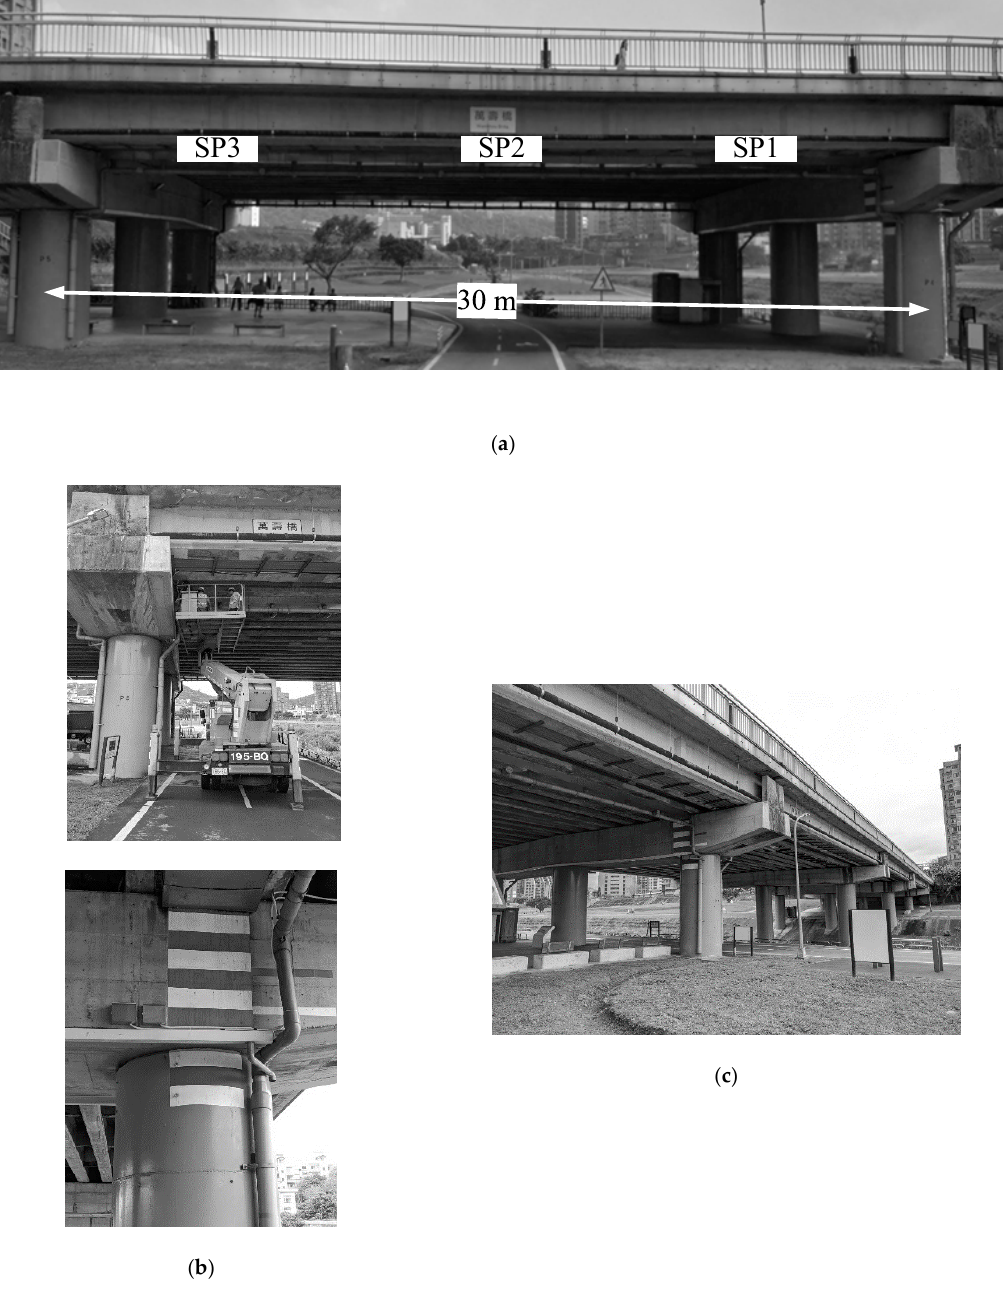
Figure 26. ( a ) Sensor positions and bridge dimension; ( b ) power supply for accelerometer and NB-IoT; ( c ) side view of Wenzhou bridge.